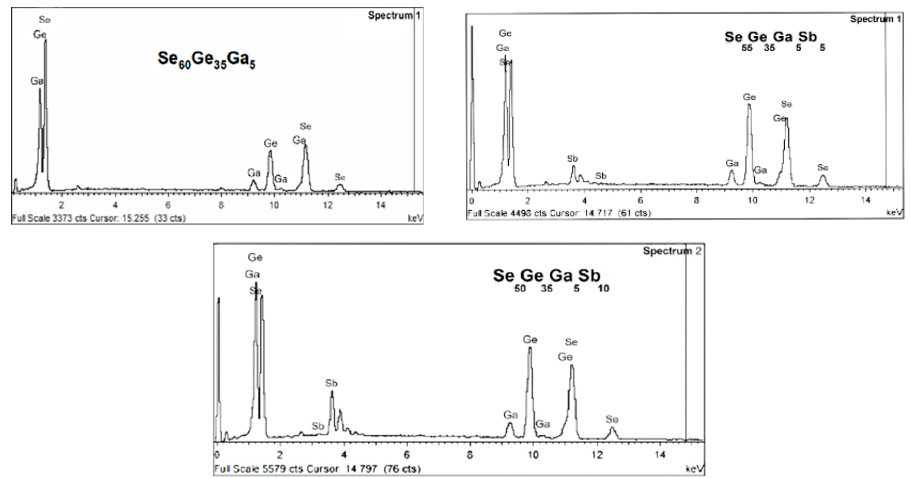
Figure 1. EDX spectra of Se (cid:2874)(cid:2868)(cid:2879)(cid:3051) Ge (cid:2871)(cid:2873) Ga (cid:2873) Sb (cid:3051) at ( x = 0, 5, 10 at. %) samples. Figure 1. EDX spectra of Se 60 − x Ge 35 Ga 5 Sb x at ( x = 0, 5, 10 at. %)